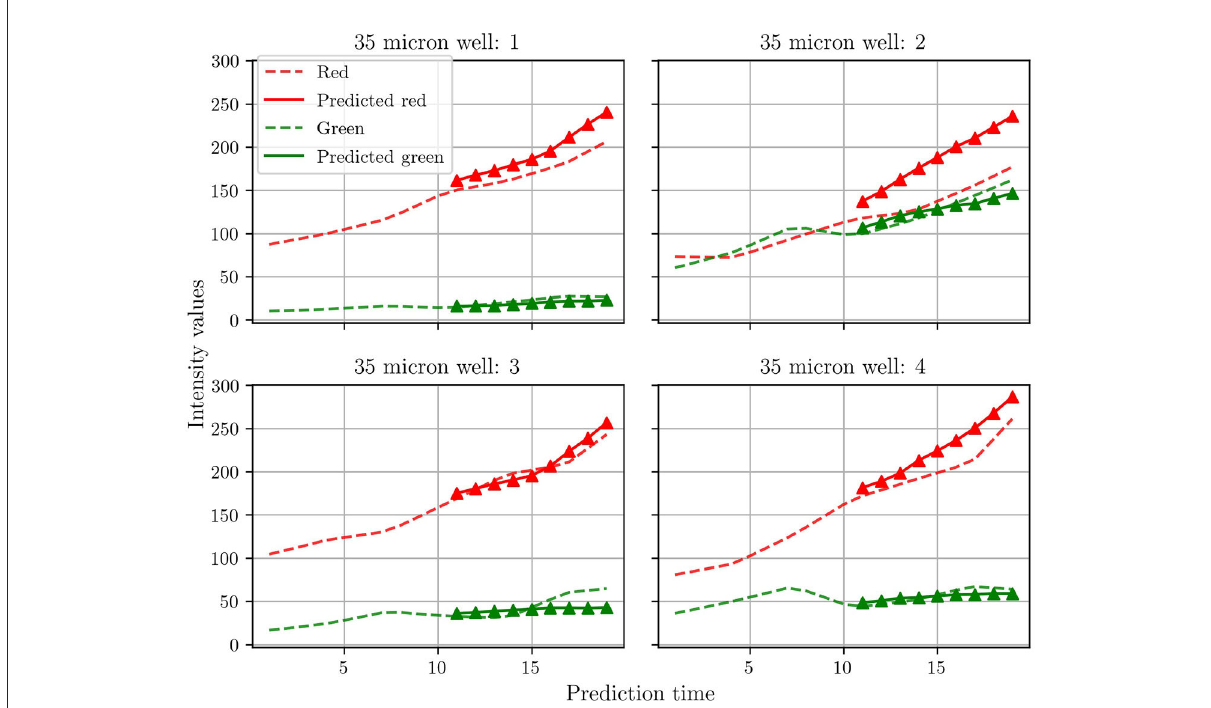
FIGURE6 Comparisons between the population curve extracted from the groundtruth frames and the corresponding predicted population curves. See text for an explanation of how the population curves were